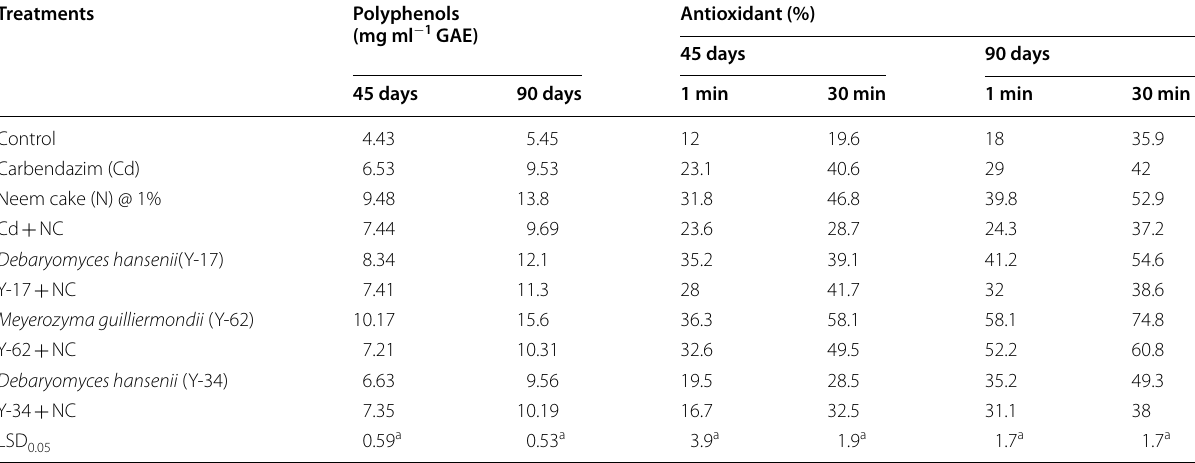
a Mean values in column showing differences greater than LSD values are significantly different at p < 0.05